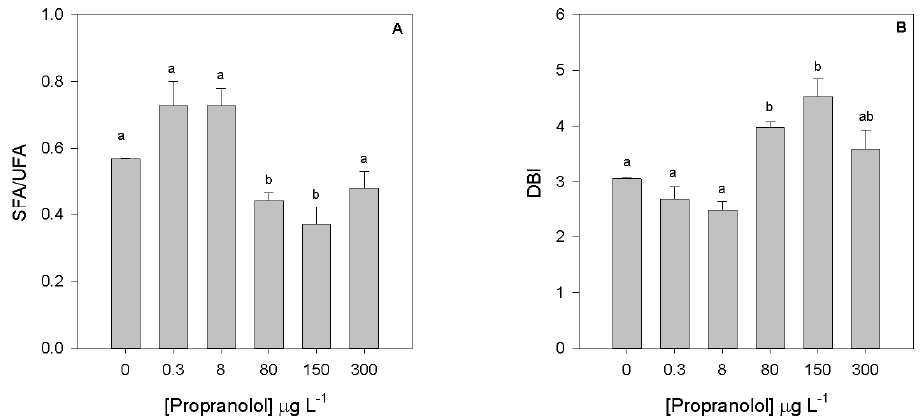
Figure 9. Saturated to unsaturated fatty acid ratio ( A ) and fatty acid double-bound index ( B ) in Phaeodactylum tricornutum cultures exposed to different propranolol concentrations (average, n = 3, letters denote differences at p < 0.05).